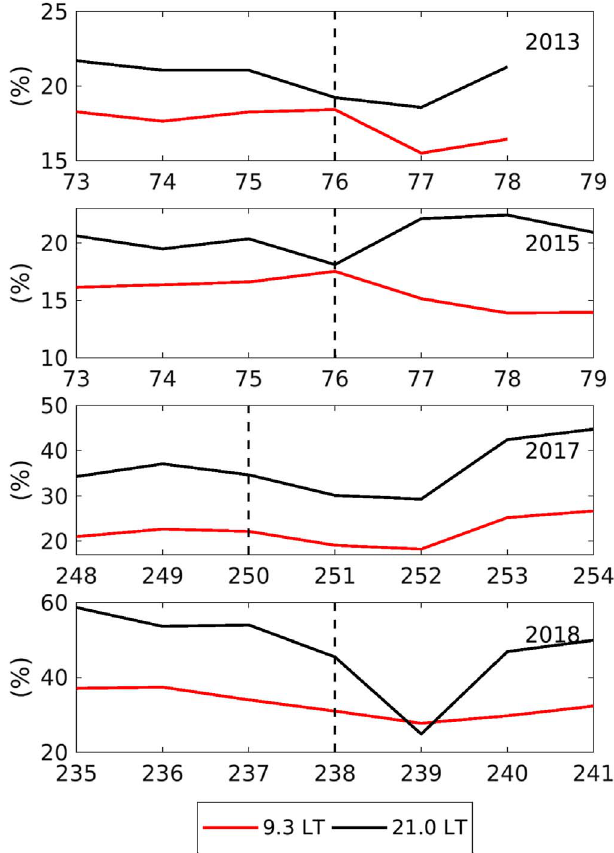
Fig. 8. Percentage contribution of the plasmaspheric VTEC to the global VTEC derived from the JPL GIMs for 9.3 and 21.0 LT. The dashed lines indicate the day of the storm